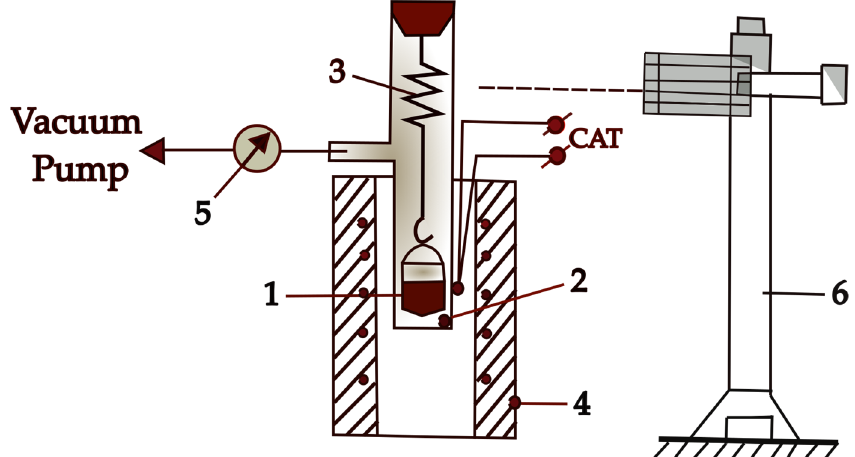
Figure 1. Unit intended to determine the total steam pressure by the boiling point method.